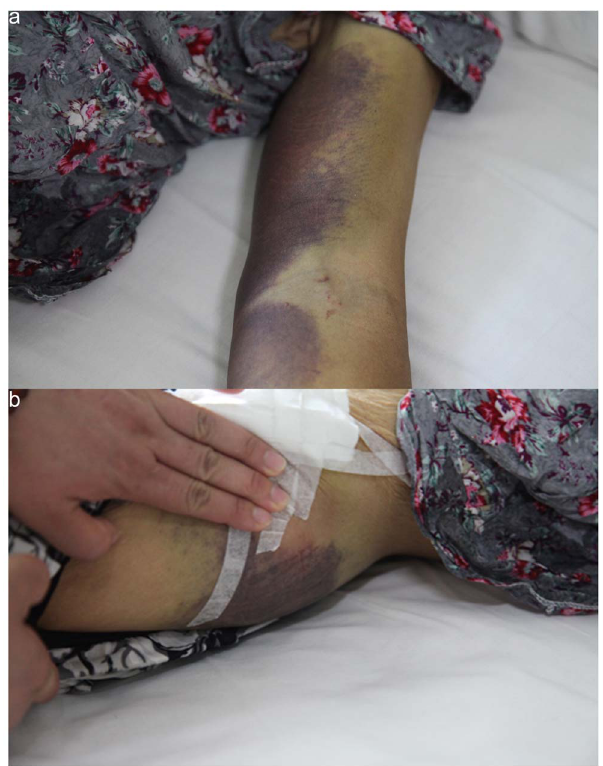
Figure 2. Bleeding exhibited in arm (a) and buttock (b) of a patient infected with HYSV in